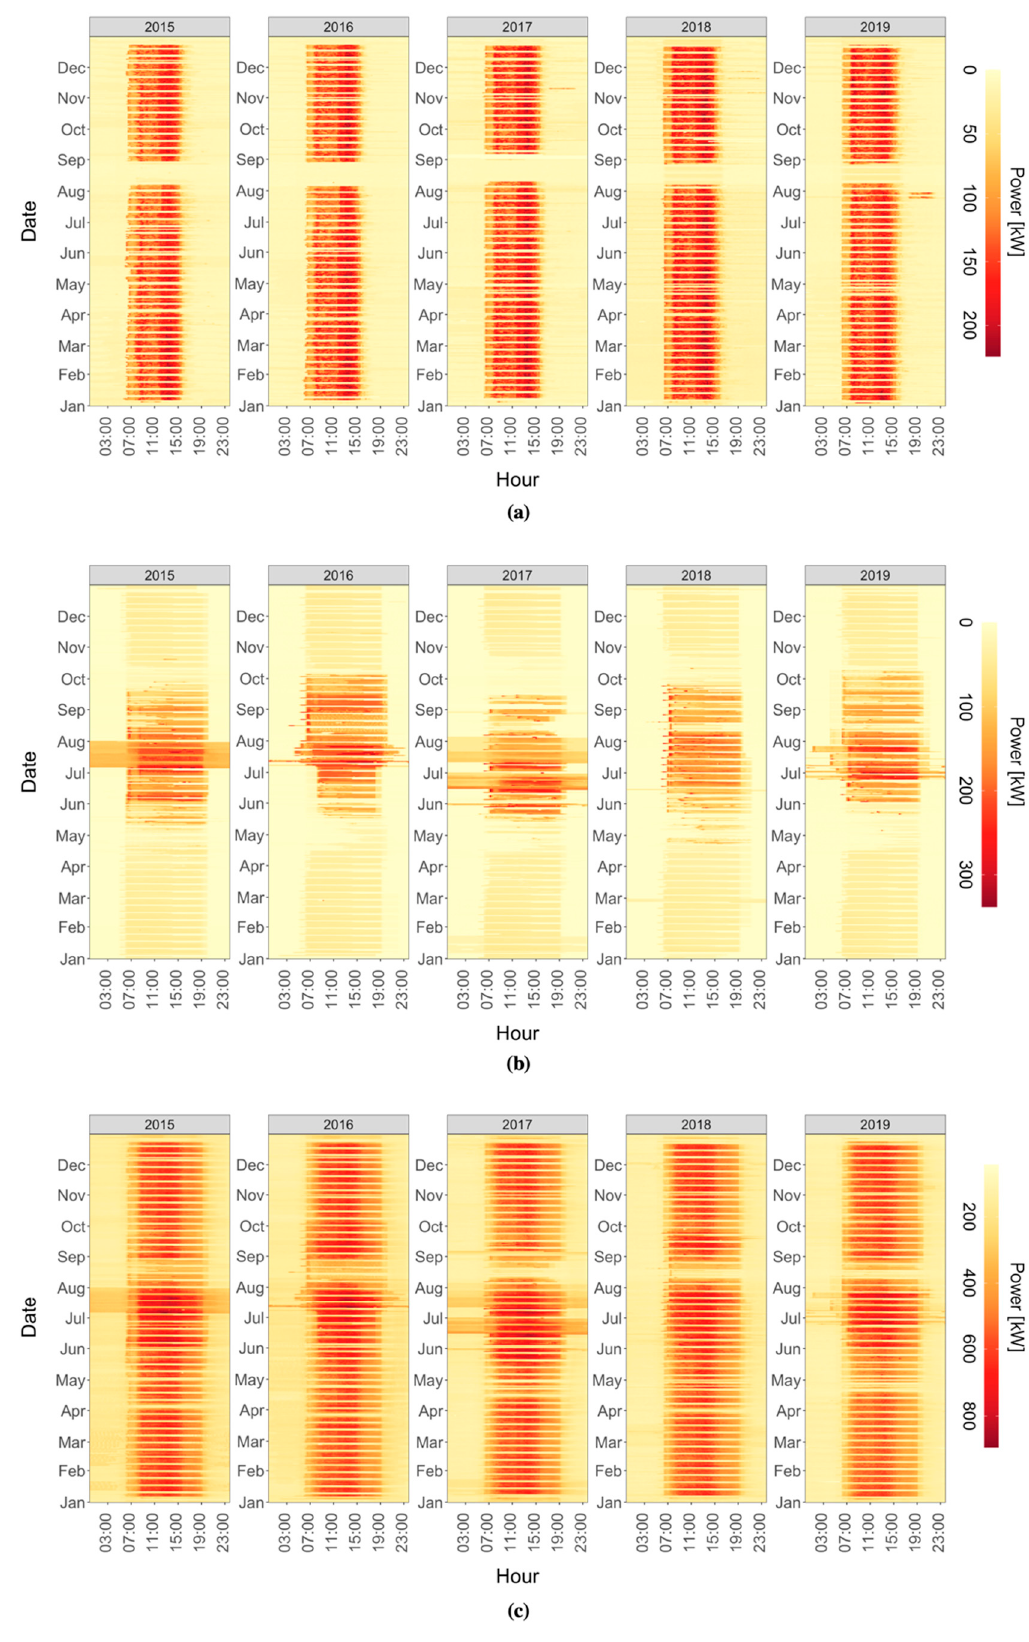
Figure 7. Carpet plot of the ( a ) total electrical load (substation C) ( b ) mechanical room ( c ) canteen.